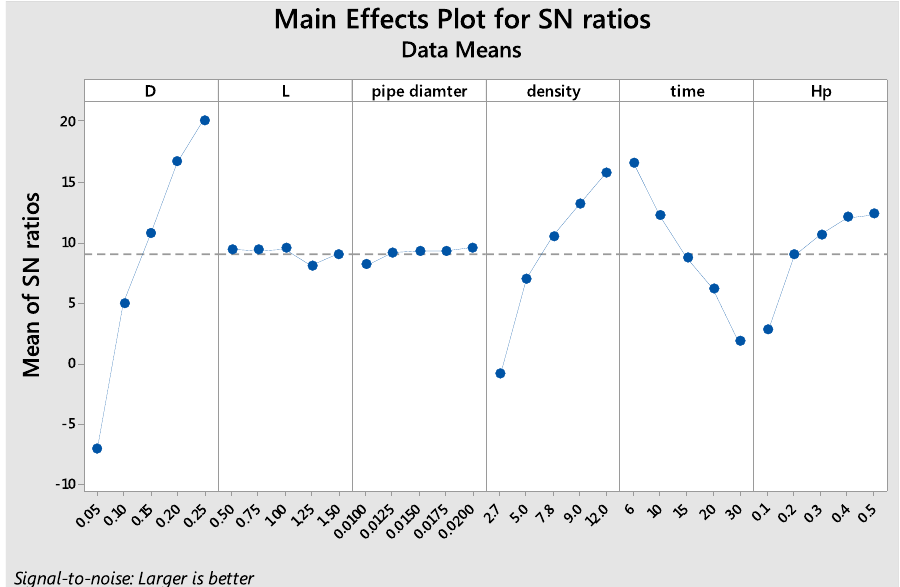
Figure 9. Signal-to-noise ratio on each factor.